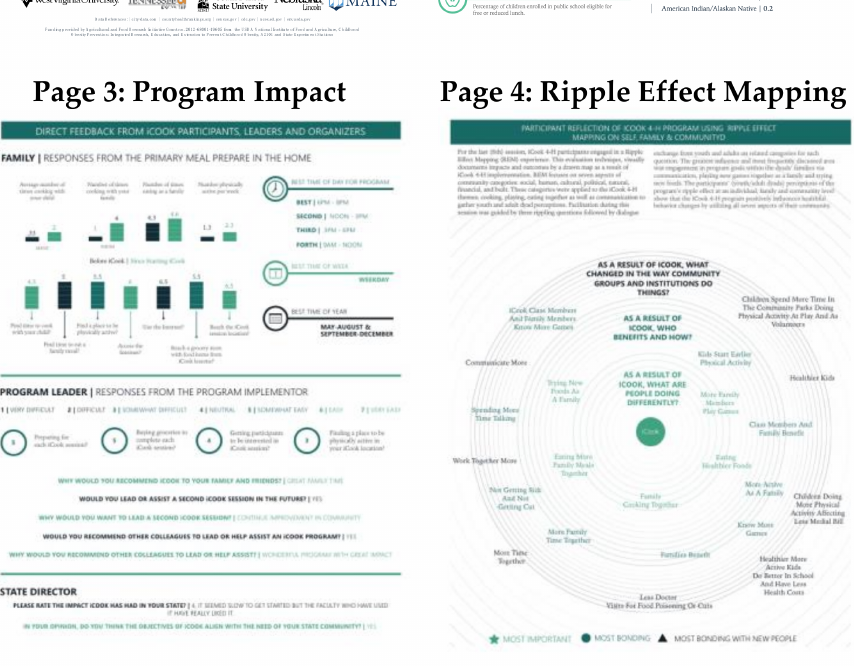
Figure 2. Sample eB4CAST infographic reports from iCook